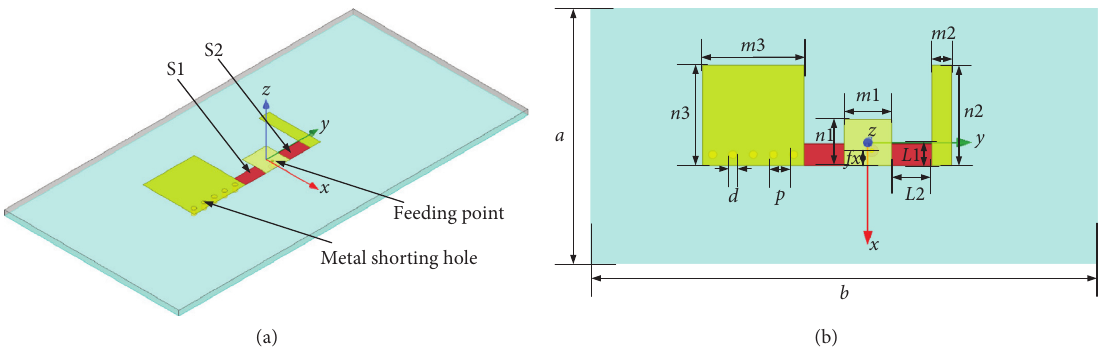
Figure 1: Geometry of the proposed FRA element. (a) 3D view. (b) Front view (unit (mm): a � 17.0, b � 34.0, m 1 � n 1 � 2.3, m 2 � 1.0, n 2 � 5.0, m 3 � n 3 � 5.0, d � 0.4, p � 1 . 0, L 1 � 1.1, and L 2 � 2.0).